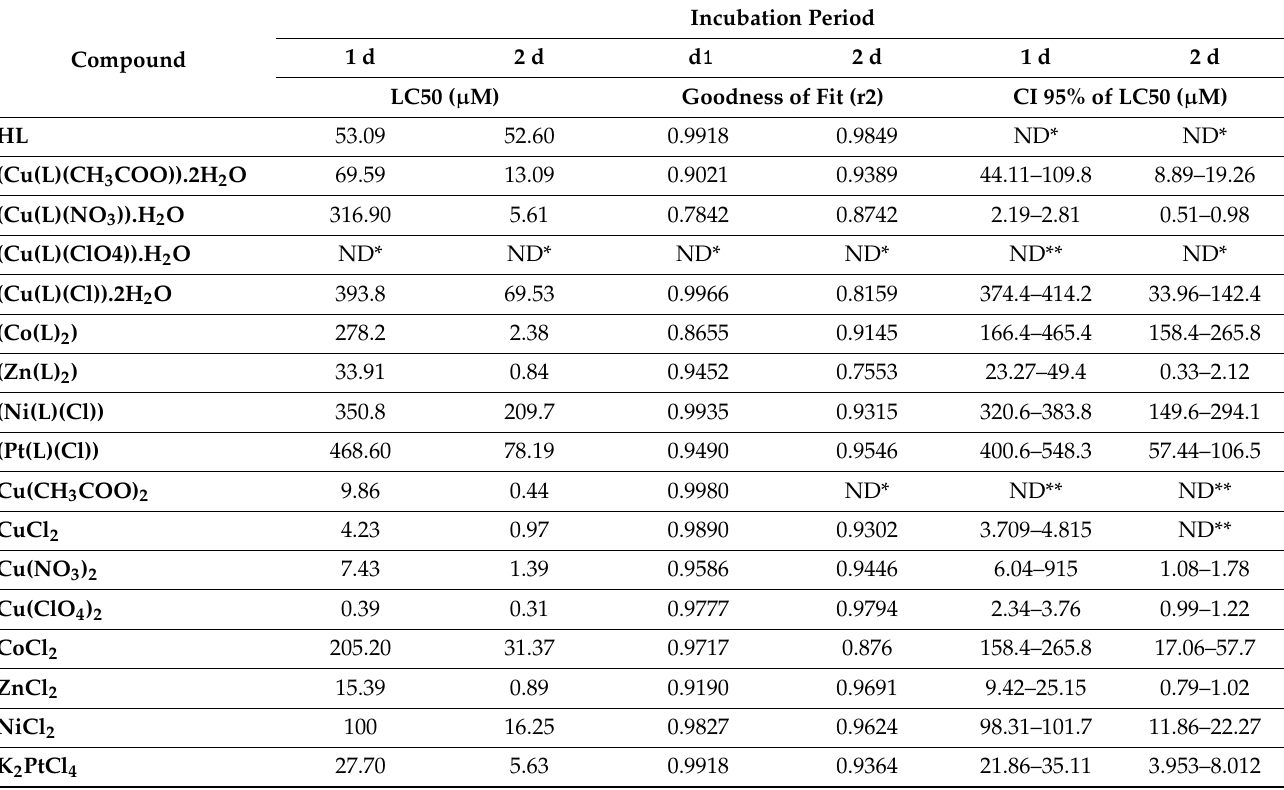
Table 6. Toxicity of HL, metal salts, and newly created complexes on Daphnia